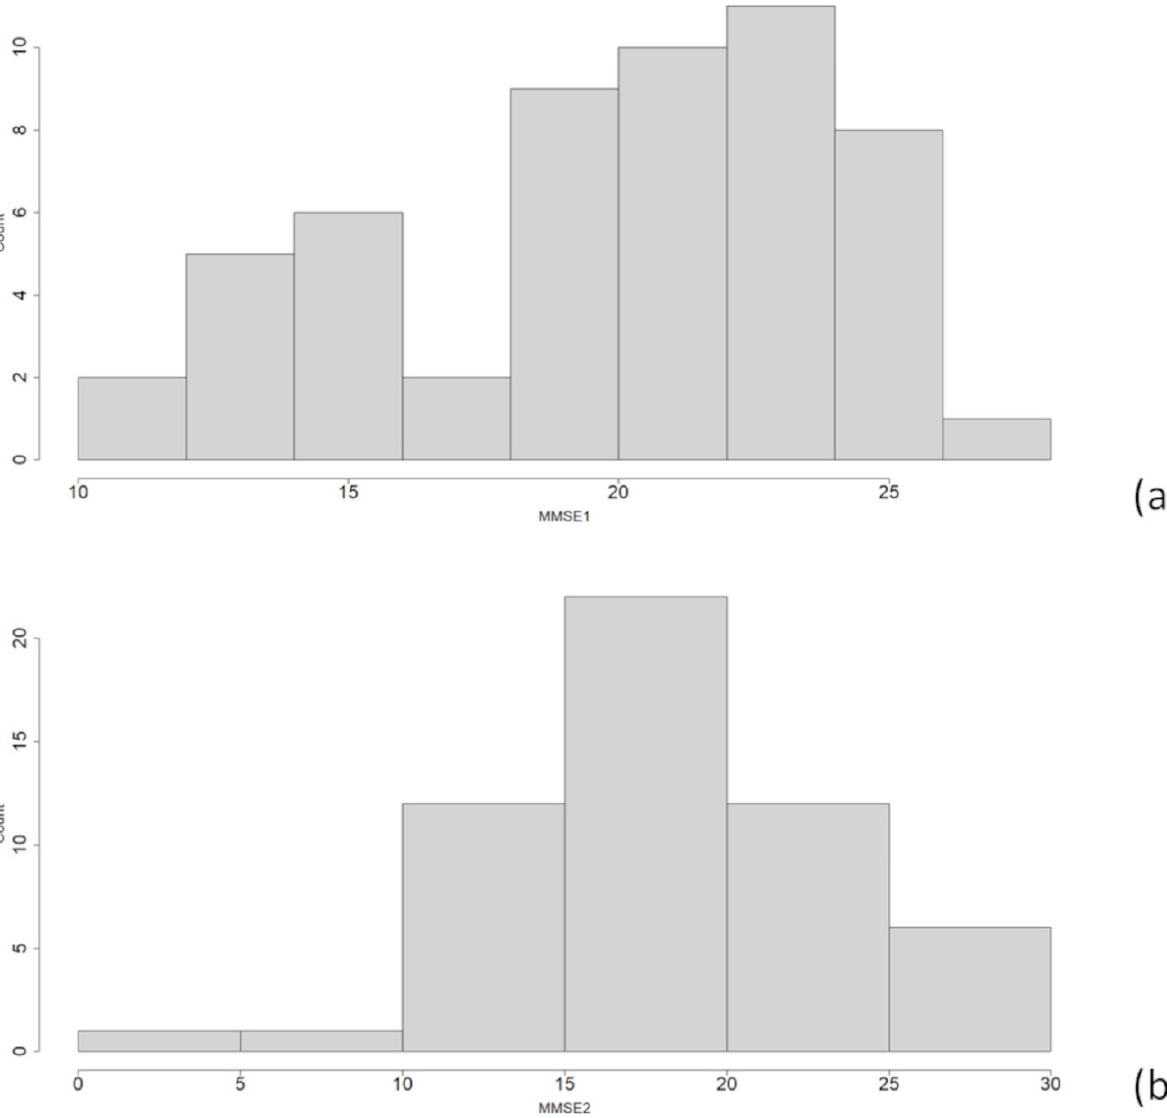
Figure 1. MMSE1 ( a ) and MMSE2 ( b ) distribution throughout the dataset.